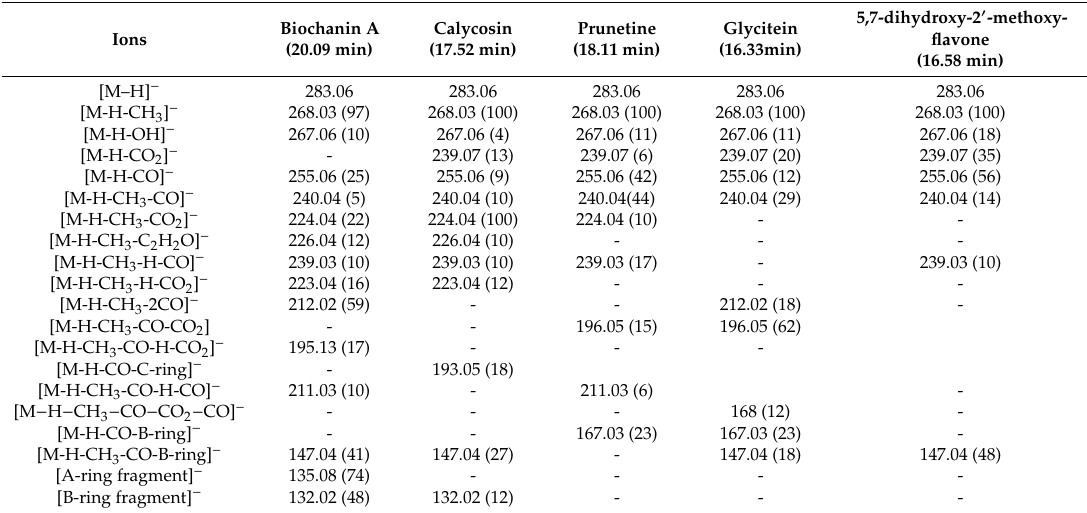
Figure 1. Extracted chromatograms for [M − H] − 286.06, full MS 2 (50–330 m / z ). The isomeric peaks were assigned to ( 1 ) glycitein, ( 2 ) calycosin, ( 3 ) prunetin, and ( 4 ) biochanin A. Table 3. Key ions in HRMS-MS spectra ( m / z with relative abundances (%) in parenthesis) for the identification of biochanin A and